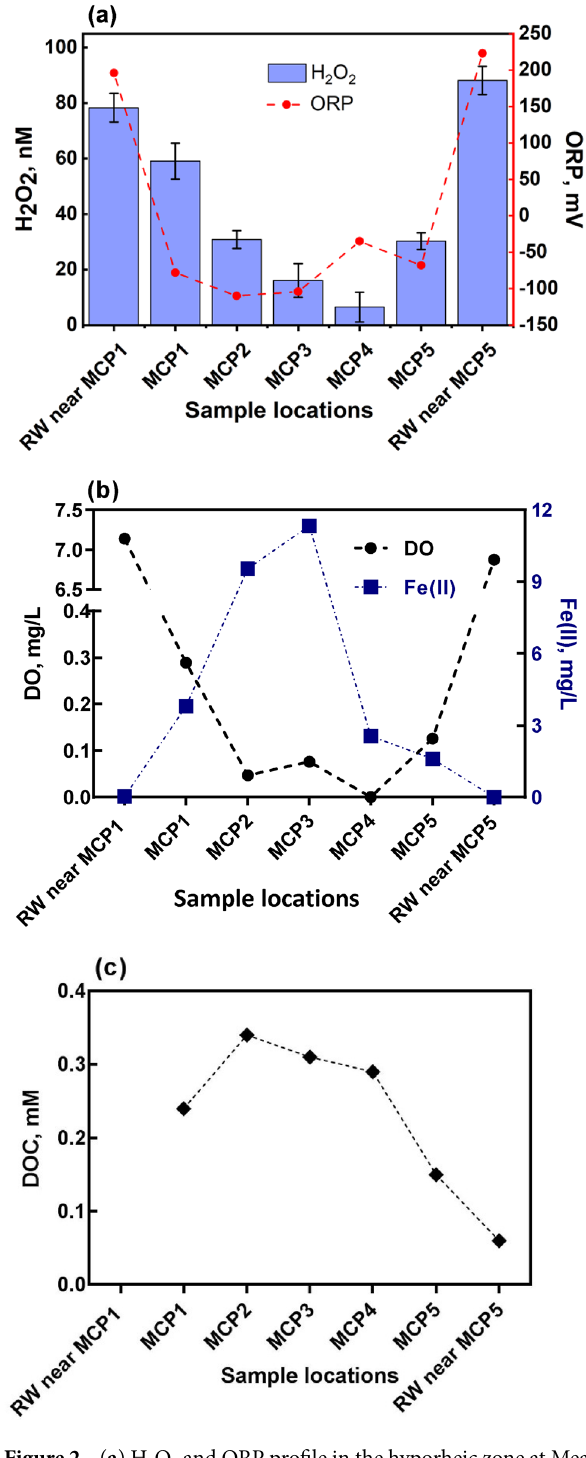
Figure 2. ( a ) H 2 O 2 and ORP profile in the hyporheic zone at Meander C Transect. The first and last columns are results from surface water samples taken at the river adjacent to MCP1 (RW near MCP1) and MCP5 (RW near MCP5), respectively. Error bars are the standard errors from triplicate measurements. ( b ) Profiles of DO (left Y axis with two segments) and Fe(II) (right Y axis) in the hyporheic zone and surface river water at Meander C transect. ( c ) DOC concentrations across the hyporheic zone and in river water near